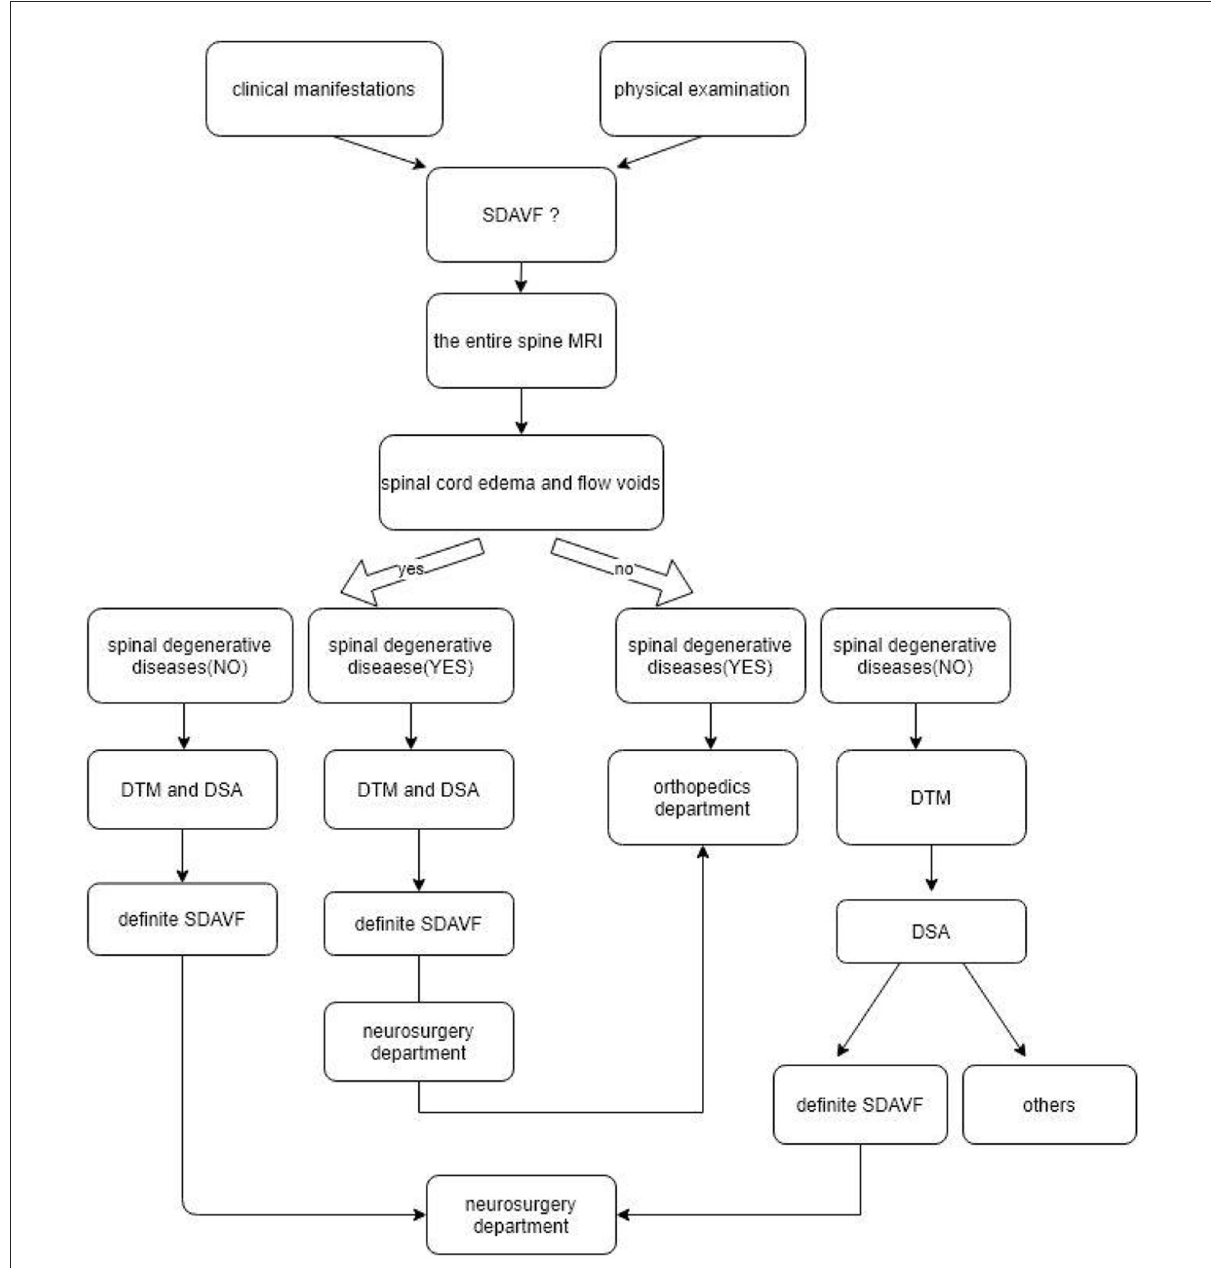
FIGURE4 A detailed diagnosis and treatment flowchart for orthopedic surgeons.